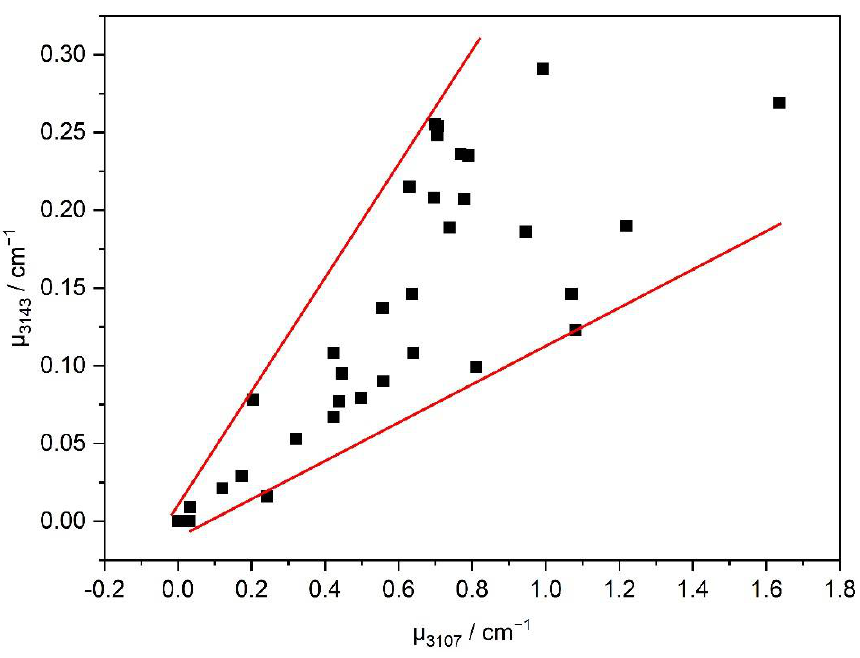
Figure 4. Variation of the absorption coefficient at 3107 cm −1 and 3143 cm −1 from 35 natural type Ib diamond samples containing isolated nitrogen we studied, which can detect an obvious 3143 cm −1 absorption line.